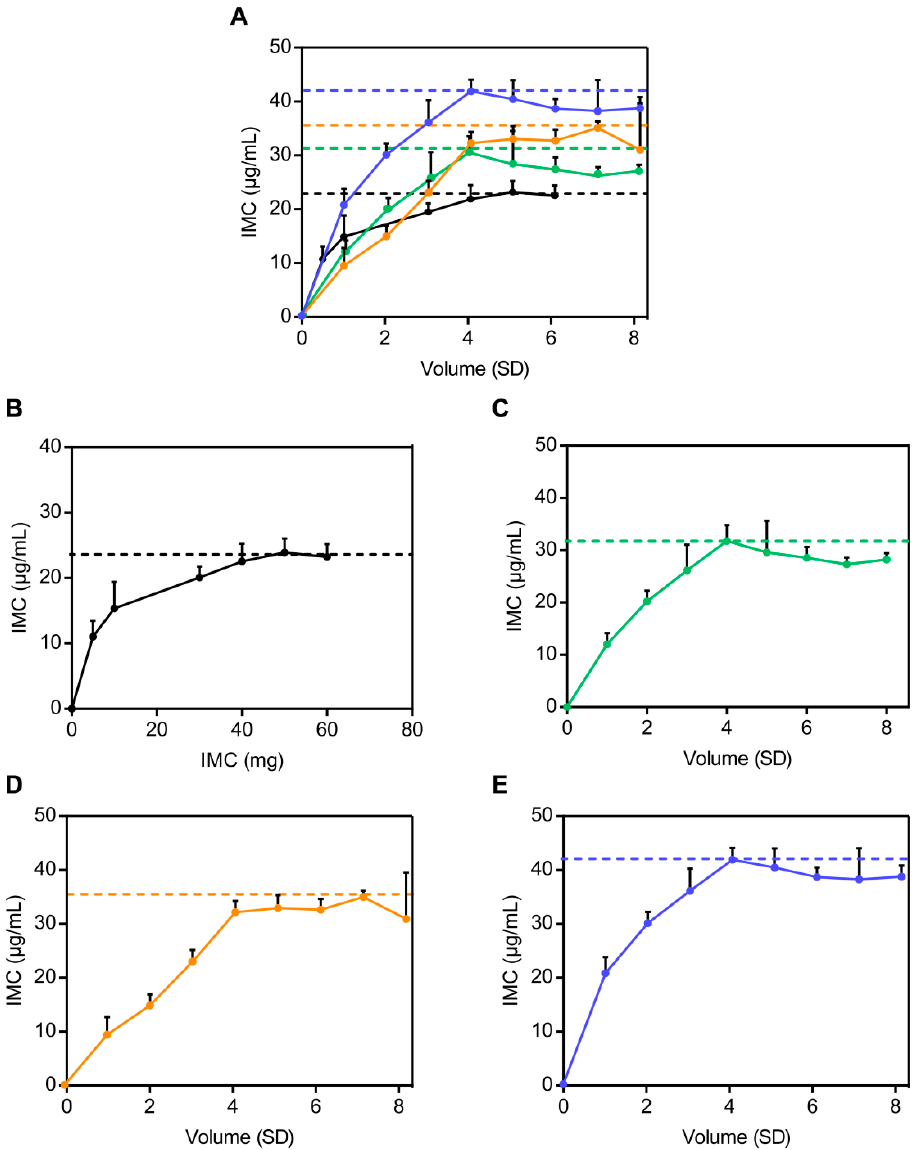
Figure 5. The solubility of ( A ) all of the formulations; ( B ) IMC; ( C ) IMC–MSNs (F3); ( D )